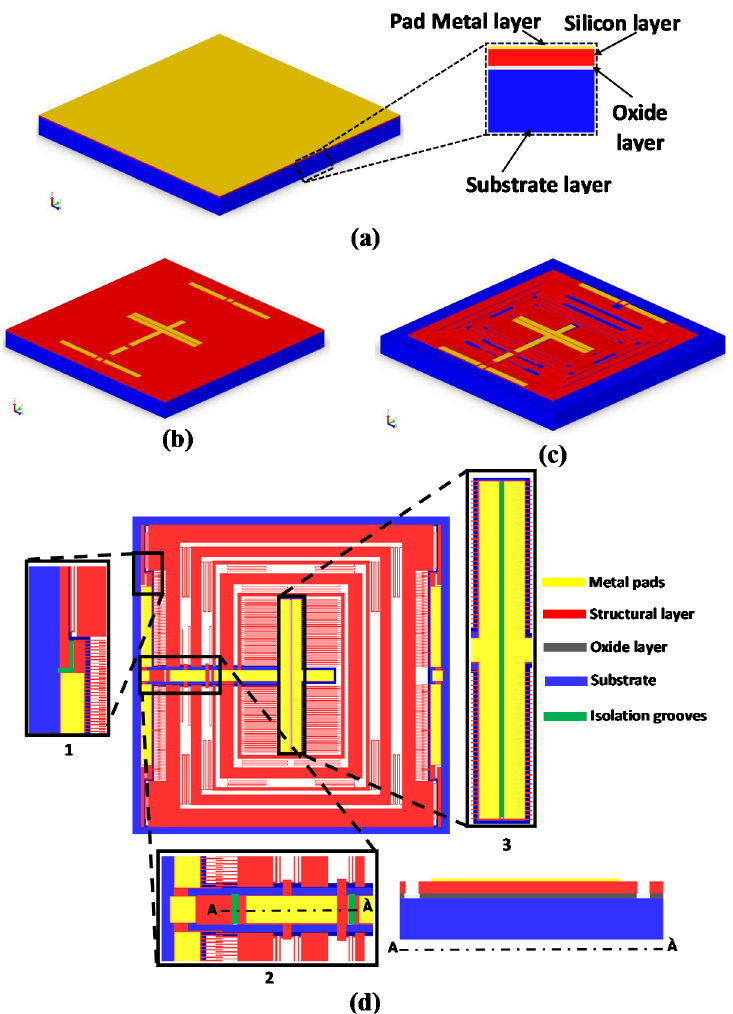
Figure 2. Microfabrication process steps for the proposed MEMS gyroscope